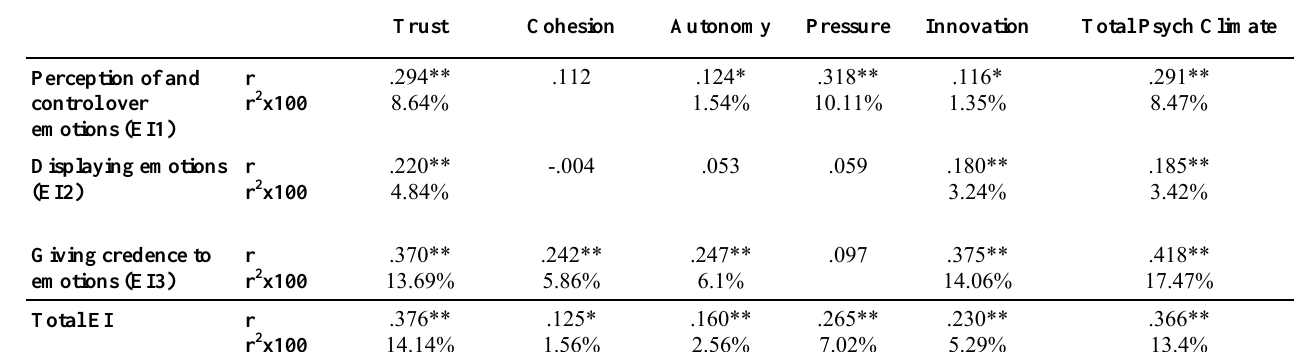
Table 5: Pearson correlations coefficients